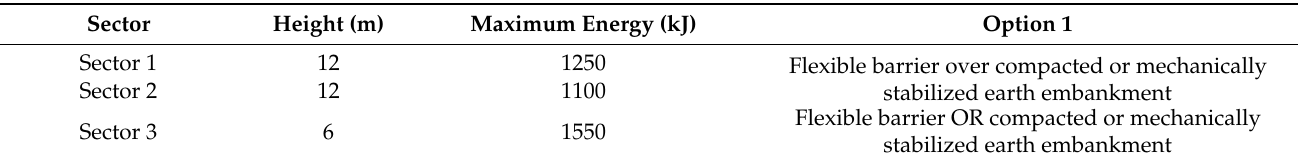
Figure 13. Proposed layout of rockfall protection for Option 1 ( a ) and Option 2. Trajectories reaching the different sectors are plotted for Phases 1 ( b ) 2 ( c ) and 3 ( d ) to illustrate the required sequence of installation. Table 9. Height and energy requirements for Option 2 rockfall protection. Table 8. Height and energy requirements for Option 1 rockfall